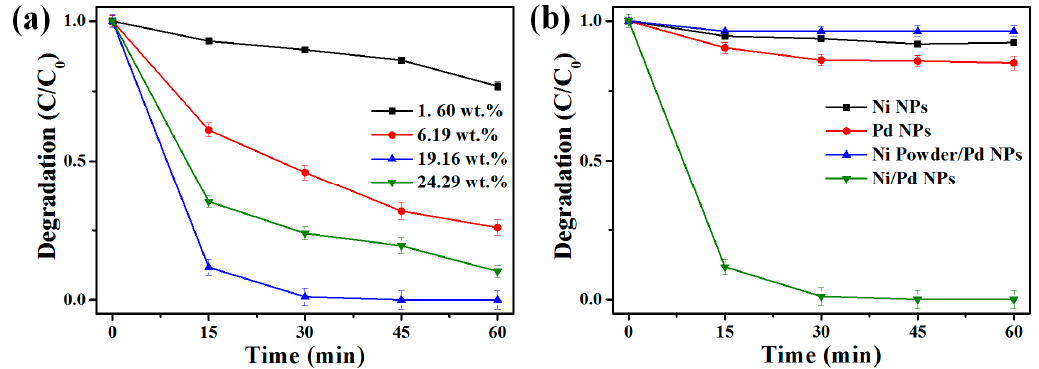
Figure 3. ( a ) Catalytic degradation of 1,2-DCB using Ni/Pd bimetallic NPs of various Pd loadings. ( b ) Catalytic degradation of 1,2-DCB for Ni, Pd, Ni powder/Pd NPs, and Ni/Pd bimetallic NPs.